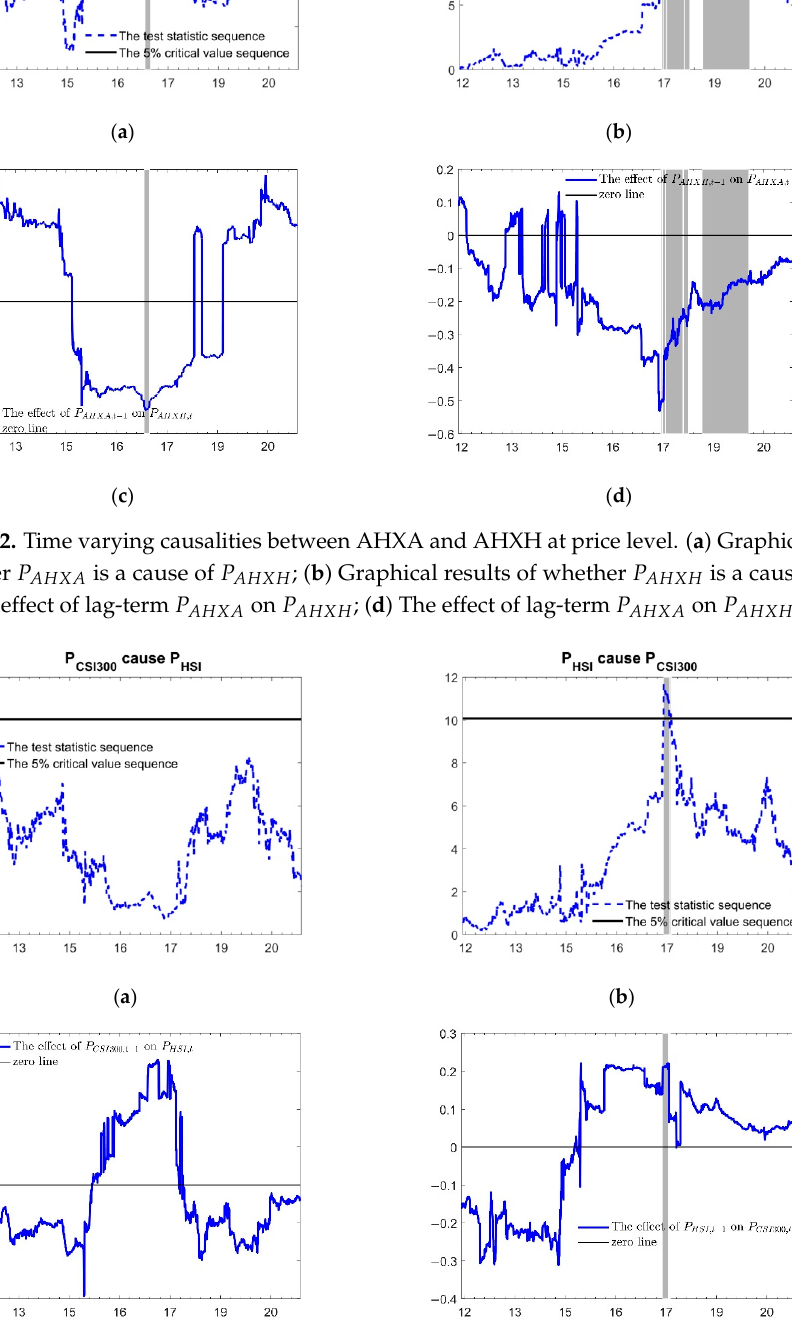
Figure 3. Time varying causalities between CSI 300 and HSI at price level. ( a ) Graphical results of whether P CSI 300 is a cause of P HSI ; ( b ) Graphical results of whether P HSI is a cause of P CSI 300 ; ( c ) The effect of lag-term P CSI 300 on P HSI ; ( d ) The effect of lag-term P HSI on P CSI 300